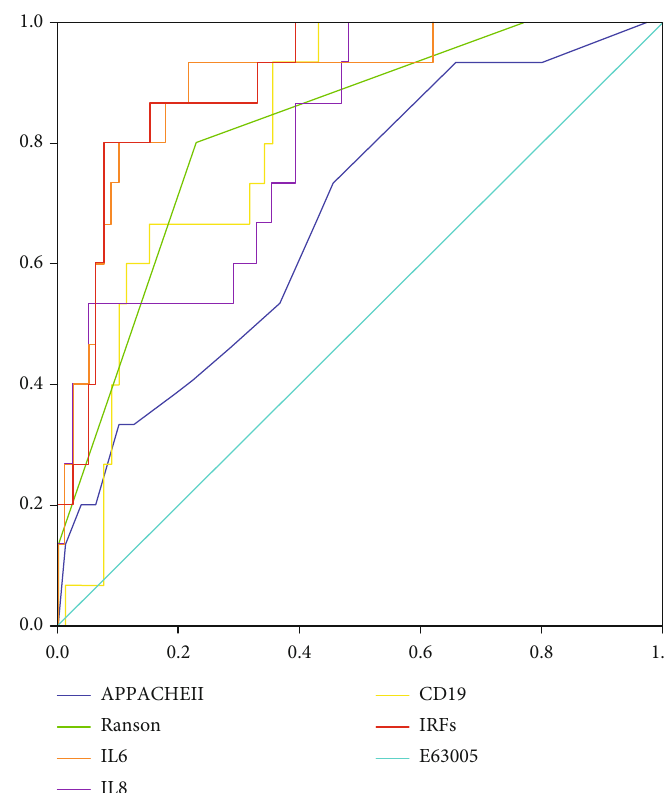
Figure 1: ROC curve analysis of the IRFs and relative clinical factors in prediction of OF.